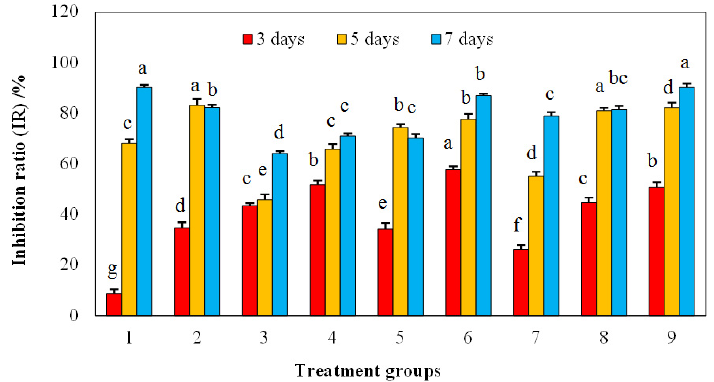
Figure 2. Influences of nine different treatments on the IR of Microcystis. aeruginosa during orthogonal testing. On the 3rd, 5th, and 7th days, significant difference of IRs among treatment groups was marked with letters a–g, respectively (p < 0.05).